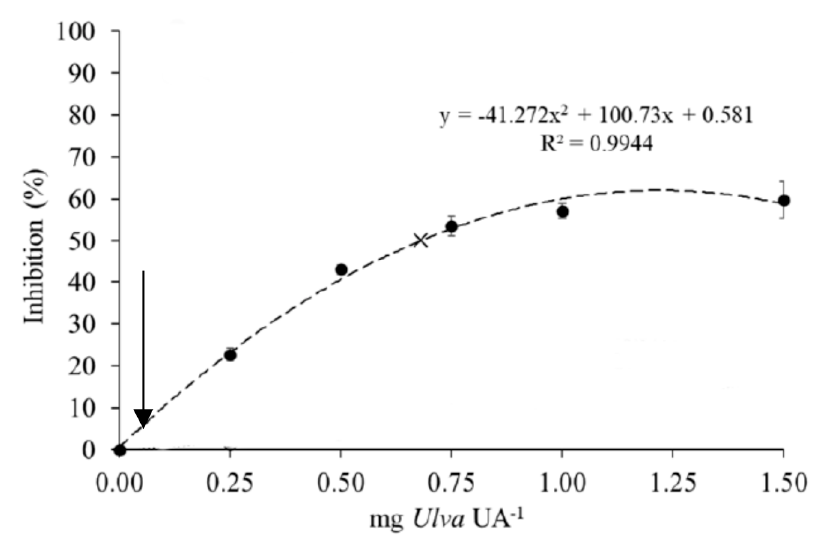
Figure 3. Inhibitory response of European sea bass intestinal proteases after incubation with increasing doses of raw or heat-treated Ulva extracts (graph adapted from Vizcaíno et al., 2020) [11]. The inhibition value (% over a control) corresponding to 0.02 mg Ulva /U activity is represented by an arrow.